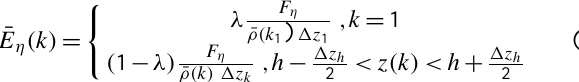
Figure 4. Carbon monoxide anthropogenic emission field generated by the PREP-CHEM-SRC program: Panel (A) for a regional grid with 15 km horizontal resolution, Panel (B) for a nested grid with 3 km. The black box on Panel (A) represents the location of the nested grid in the coarse domain.